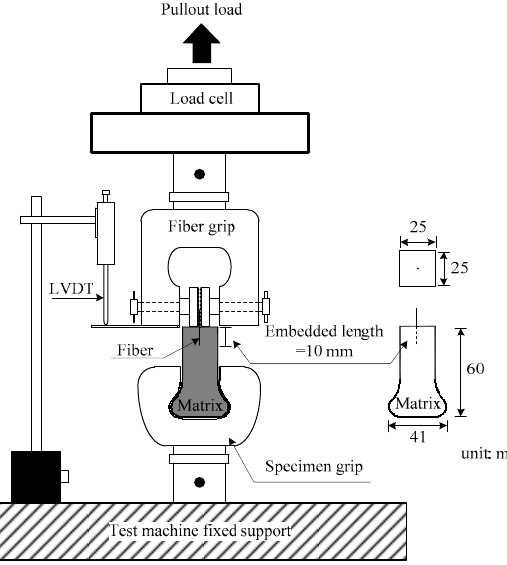
Figure 4. Single-fiber pullout test setup [26].